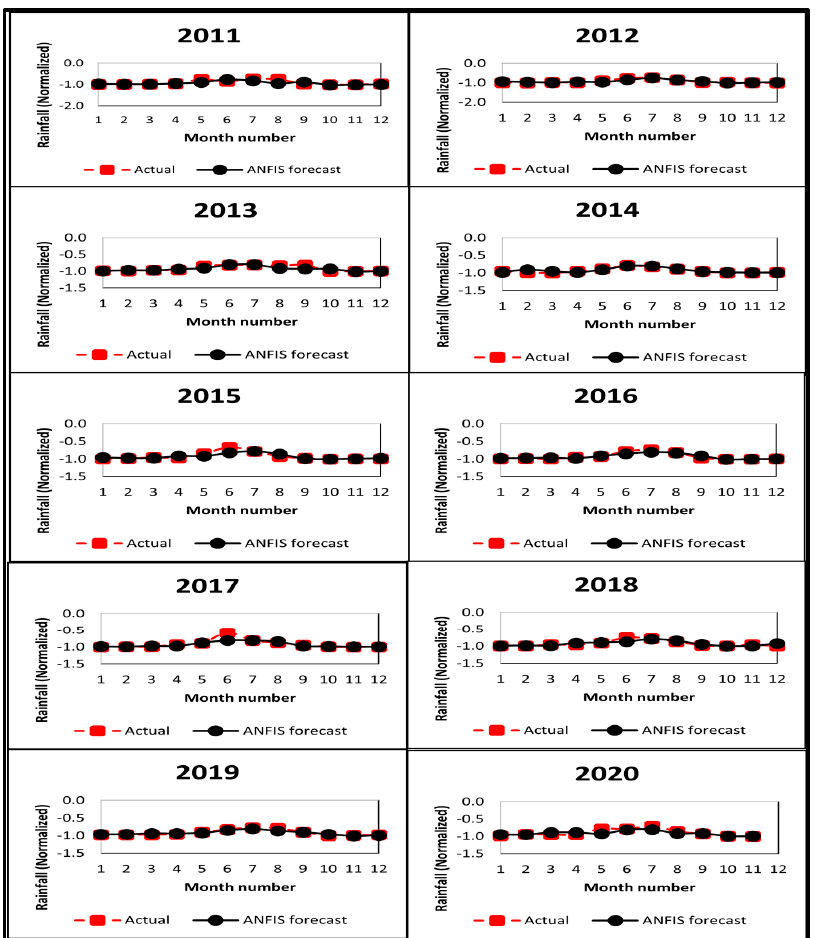
Figure 8. Comparison of forecasted results with actual ones for the period 2011 to 2020. The x -axis refers to the months from January (i.e., 1) to December (i.e., 12), the y -axis refers to the normalized rainfall, and the given year is provided at the top of each graph.